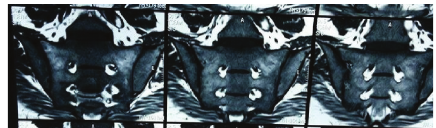
Figure 1: MRI of the sacroiliac joints with bilateral bone marrow edema.